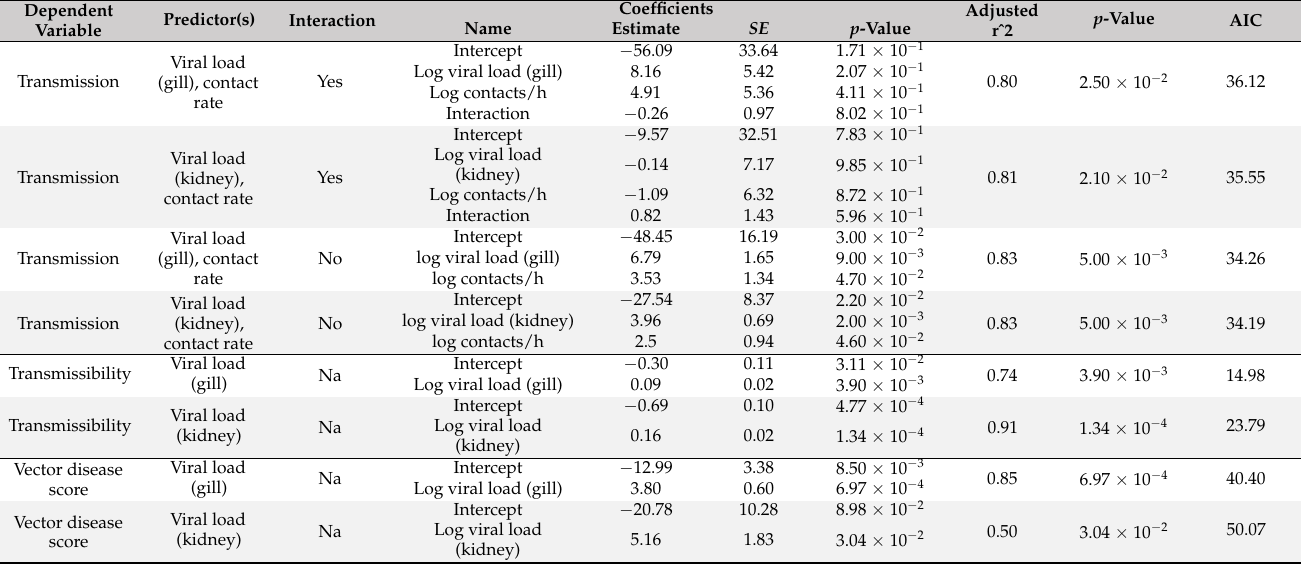
Table 3. Multiple regression analysis of viral load and contact rate as predictors of transmission, and regression analysis of viral load as a predictor of transmissibility and vector disease